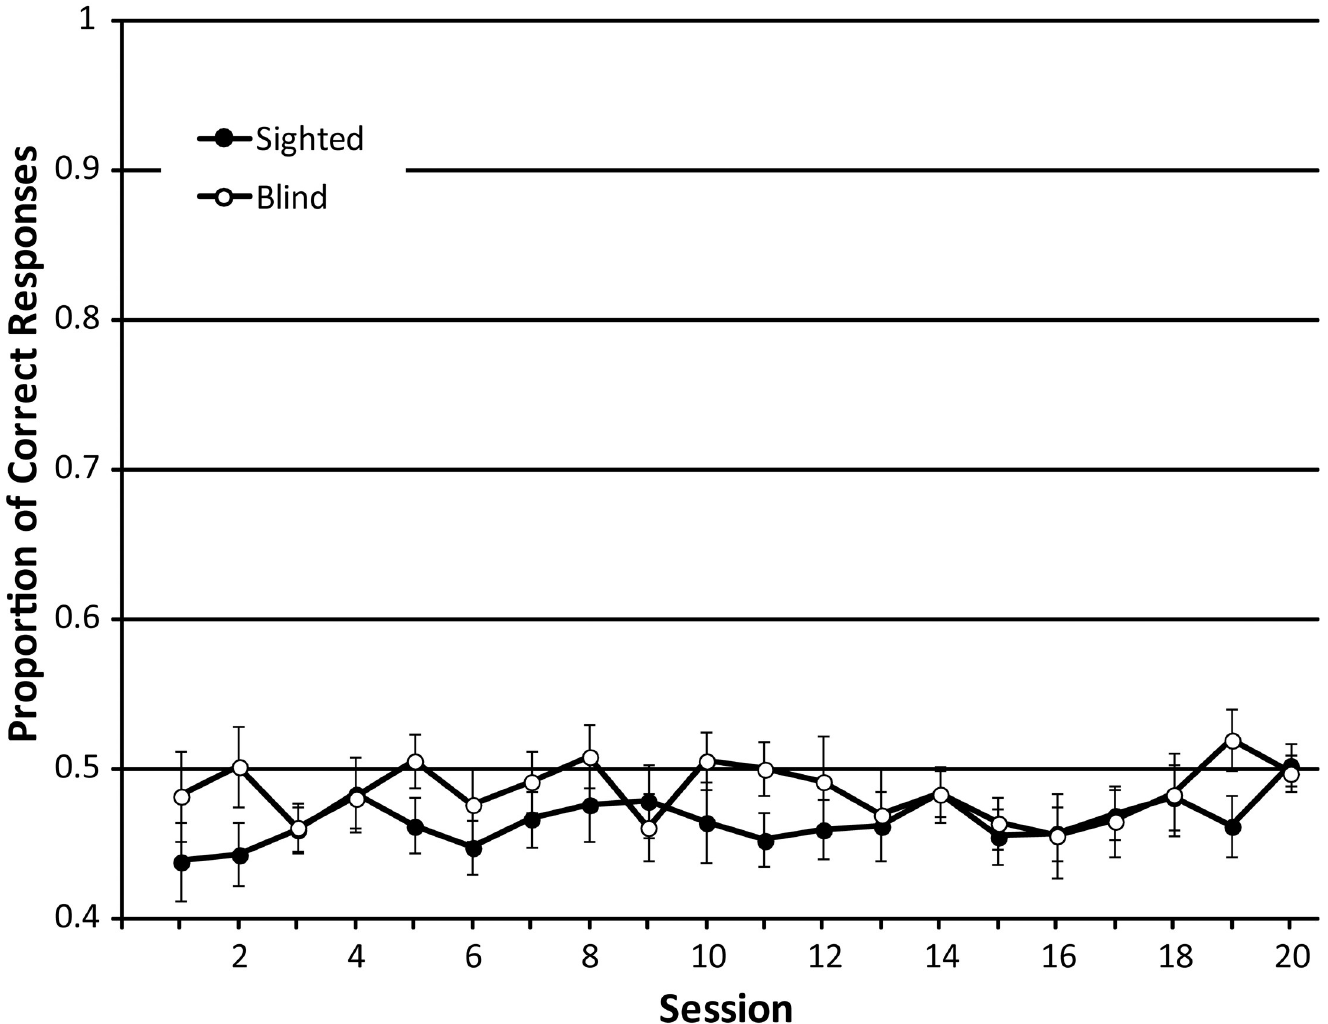
Fig 5. Proportion of correct answers across sessions in the control training task. Chance level for proportion correct is.5. Data from SCs and BCs are shown as black and white circles respectively, with each symbol representing the average and error bars representing the standard error of the mean across